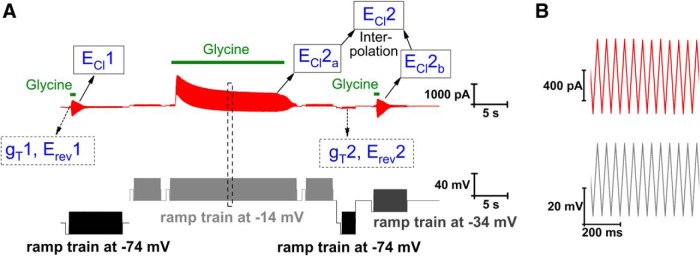
 Protocol used for estimation of relative Cl– conductance at rest. A, Voltage protocol (below in black/gray; ramp sequences appearing as blocks; for detailed ramps, see B) and recorded current (top, red), with glycine application as indicated by the green bars (short bars, 100 µM; long bar, 1.0 mM). B, Voltage protocol (bottom) and recorded current (top) for part of the ramp train shown within dashed box in A.